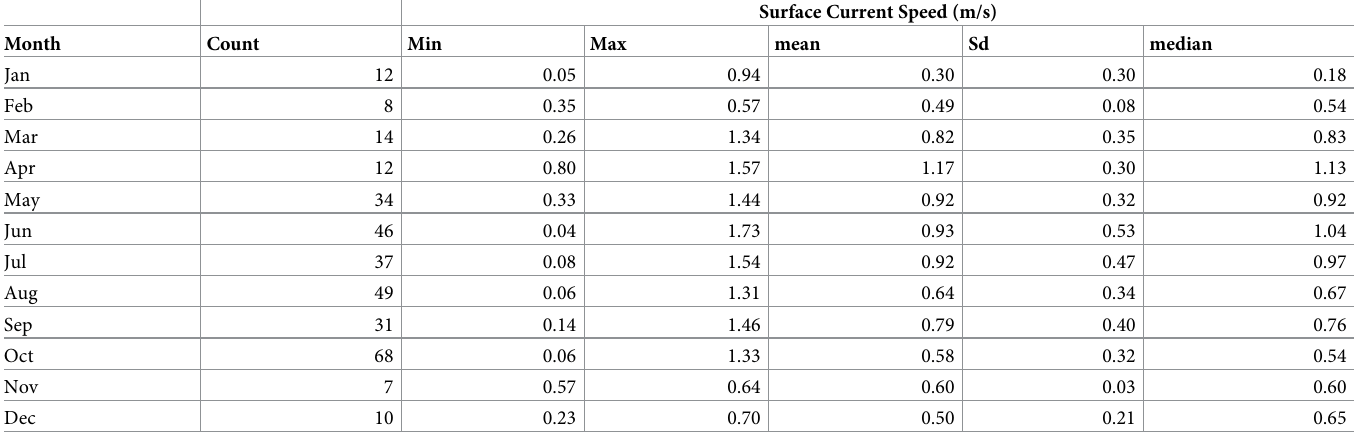
Table 4. Monthly Statistical metrics of surface current speed from the drifters in the Pemba